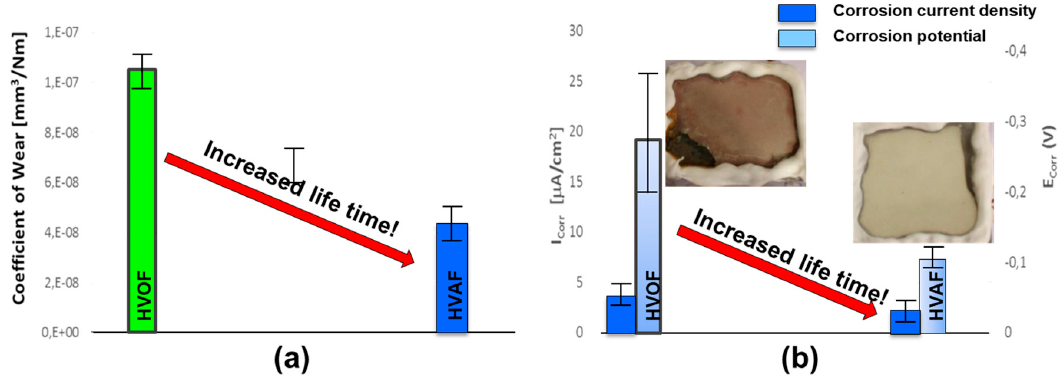
Figure 3. Studies showing superior ( a ) wear and ( b ) corrosion behavior of HVAF WC-CoCr coatings compared to the corresponding high-velocity oxy-fuel (HVOF) coatings. While ( a ) depicts the coe ffi cient of wear (in mm 3 / Nm) under abrasive wear conditions, ( b ) compares the corrosion current density, I corr (A / cm 2 ), and the corrosion potential (E corr / V) for HVOF and HVAF coatings deposited using identical feedstock.